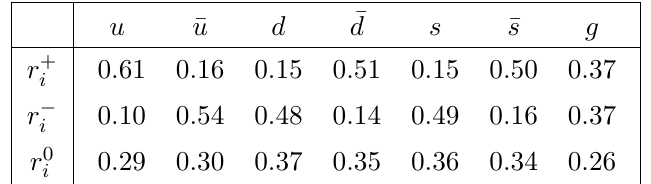
Table 3 . The jet charge bin fractions r ± , 0 for various jet flavors from Pythia8 simulation, where i the jet charges are defined using all charged-hadrons inside the